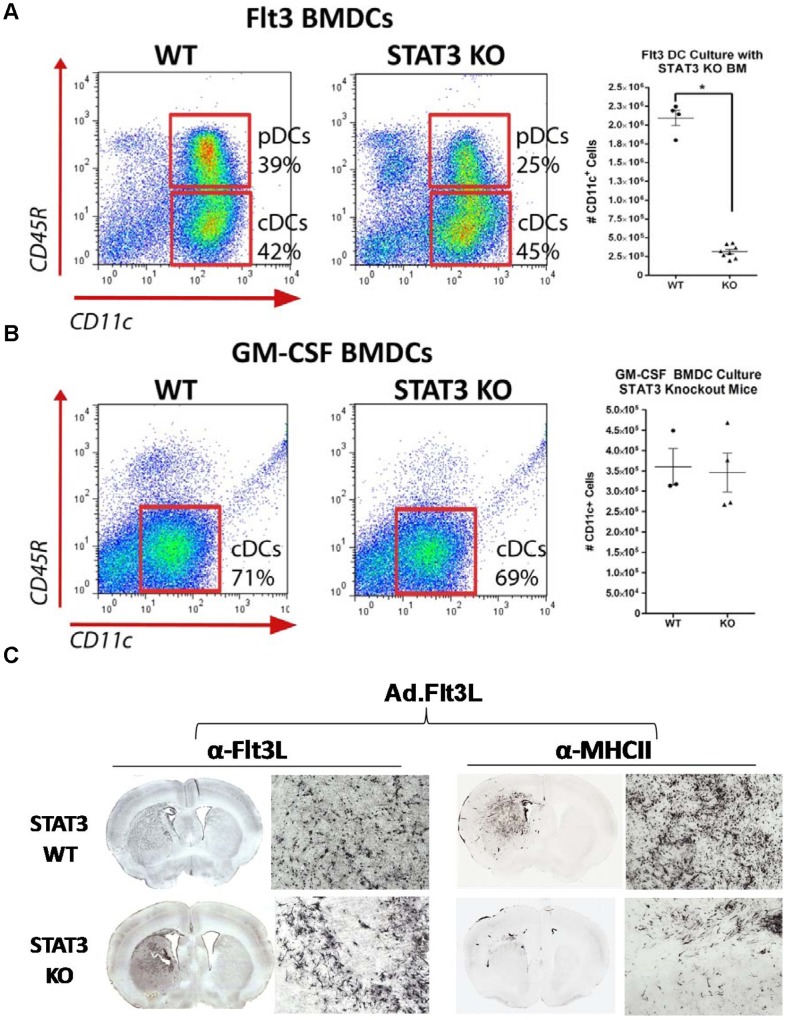
The role of STAT3 signaling in the differentiation and expansion of DCs by Flt3L and GM-CSF.
A. WT and STAT3 null bone marrow cells were cultured in the presence of hFlt3L (100 ng/ml) for 8 days then subsequently analyzed by flow cytometry for DC subtypes. Expression of CD45R was used to distinguish pDCs (CD11c+/CD45R+) from cDCs (CD11c+/CD45R−). The total number of CD11c+ DCs expanded from WT and STAT3 KO bone marrow was quantified from multiple independent bone marrow cultures (*, p<0.05; two-tail students t-test). B. Flow cytometry and quantification of GM-CSF-derived (40 ng/ml) BMDCs from WT and STAT3 null bone marrow cells. C. WT and STAT3 deficient mice were injected intracranially with an Ad (1×108pfu) that expresses human soluble Flt3-L. 8 days post injection, animals were euthanized and brains were processed for histology. Flt3 positive and MHC-II positive cells were visualized using immunohistochemistry. Mosaic micrographs of brain sections were captured at 5X and 20X magnifications.